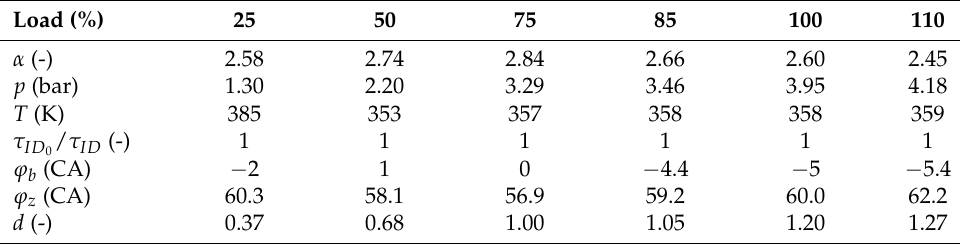
Table 4. The Wiebe parameters according to the WA model in liquid fuel